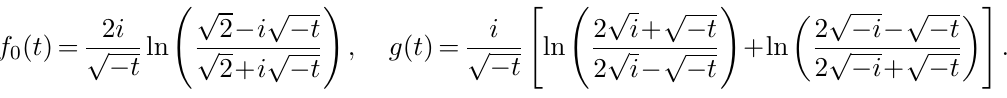
p = 1 ; 1 = 2 ; 1 = 3, M = 1 (left picture) and j j